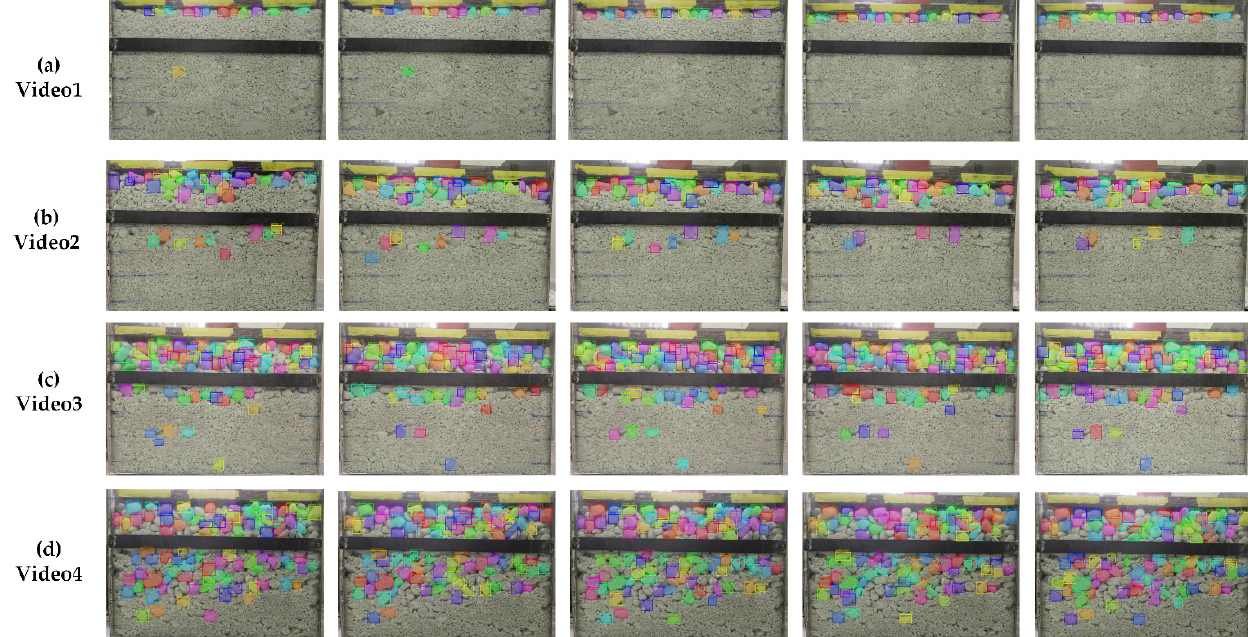
Figure 8. Experiment effect of VIS: ( a ) shows the tracking effect of video1 with a mixing degree of 80, and the proportion of coarse particles is 25; ( b ) shows the tracking effect of video2 with a mixing degree of 40, and the proportion of coarse particles is 25; ( c ) shows the tracking effect of video3 with a mixing degree of 60, and the proportion of coarse particles is 50; ( d ) shows the tracking effect of video4 with a mixing degree of 60, and the proportion of coarse particles is 75.